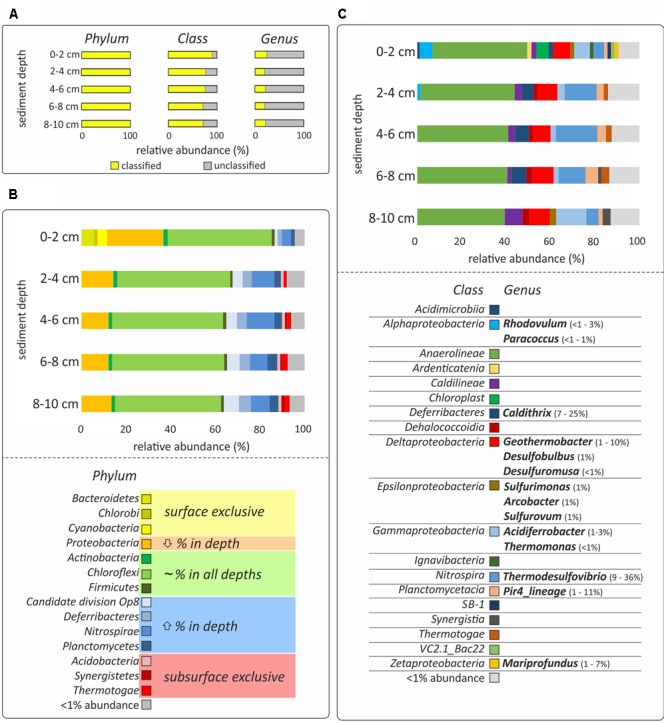
DNA-based analysis of bacterial diversity. (A) The percentage of classified and unclassified phyla, classes and genera. (B,C) Relative sequences abundances at the phylum and class level, respectively. Only bacteria with more than 1% of relative abundance are shown and the hydrothermal sediments were incubated for 48 h, which might bias the results. Classes with less than 1% presence are grouped in the category “<1% abundance.” All relative abundances in (B,C) are normalized to 100%, considering the classified sequences presented in yellow in (A). Color code in (B) indicates if the phylum was only present in surface sediment (0–2 cm; yellow), decreased its relative abundance with depth (orange), did not show relevant differences of ±5% of relative abundance in the different layers (green), increased the relative abundance with depth (blue) or was exclusive to the subsurface layers (2–10 cm; red). Genera identified as the most characteristic of the given taxonomical class and their relative abundance are presented in (C).